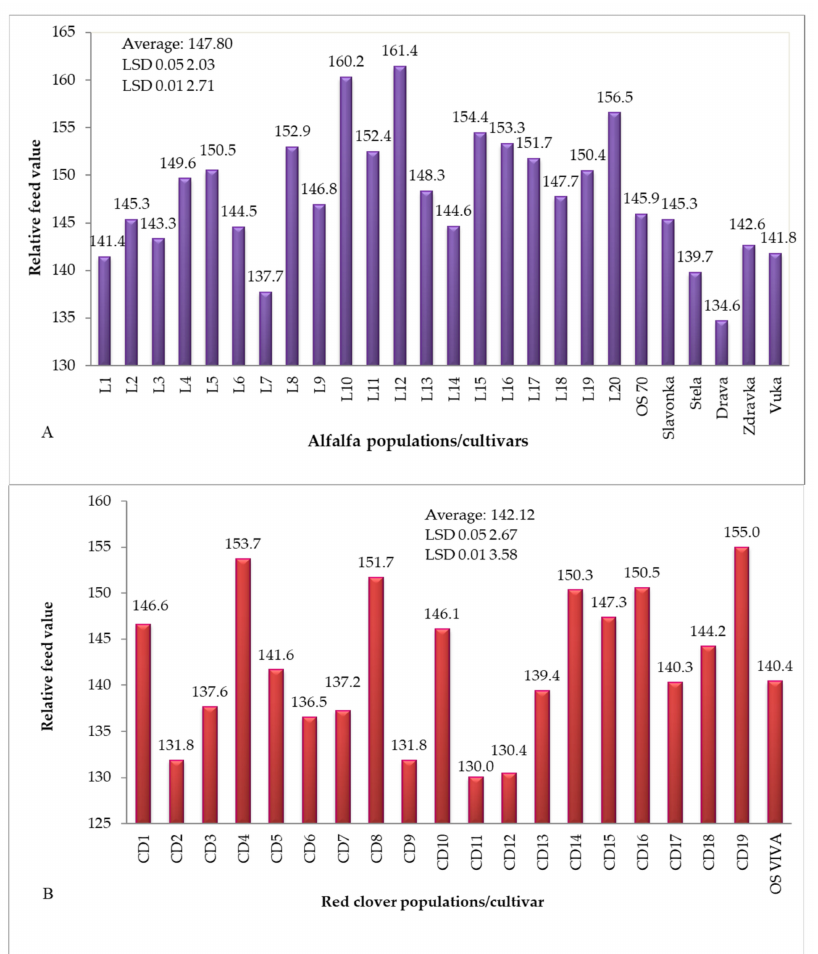
Figure 2. Relative feed value of the of the investigated alfalfa ( A ) and red clover ( B ) popula-